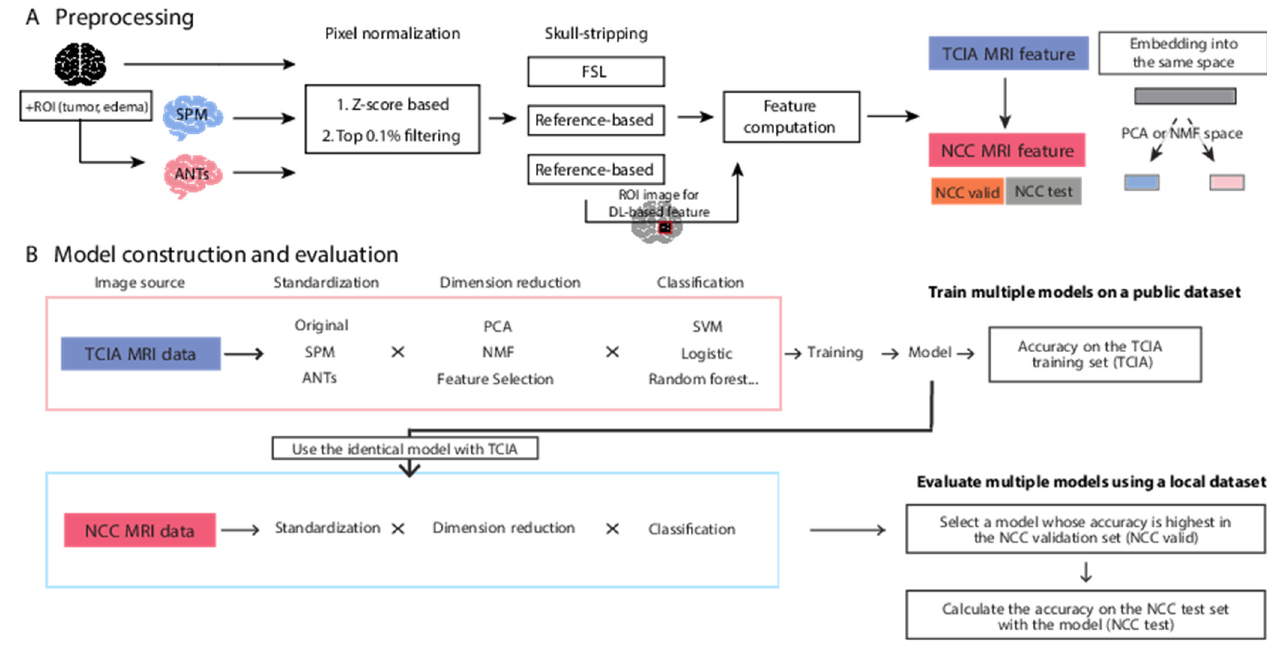
Figure 1. An overview of the dataset preprocessing and analytical methods used in this study. ( A ) Brain image data is applied to the multiple preprocessing steps; standardization of brain shape, pixel normalization, and skull-stripping. Then image features for radiogenomics are computed. To test the robustness of the trained models, we separated the whole NCC dataset to two independent partial NCC dataset: NCC validation and test set. The embedding space for dimension reduction is obtained from the TCIA dataset and applied to the partial NCC datasets independently. ( B ) In a machine learning workflow, all ML models were generated from TCIA data. The models were applied to TCIA (for cross validation), with half of the NCC data used for validation (termed NCC validation or NCC valid) and the other half of the NCC data (NCC